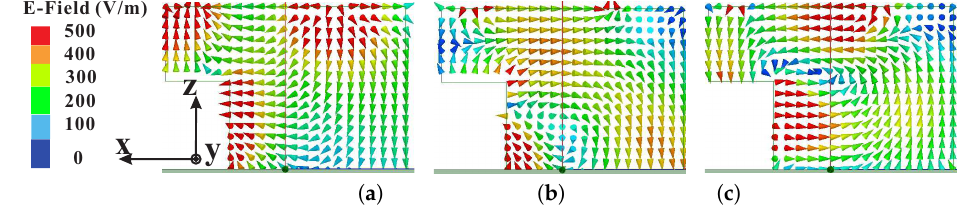
Figure 4. Simulated electric field (E-field) distribution at the center of the modified hexagonal dielectric resonator (DR) for axial ratios (ARs) minima: ( a ) 1.865 GHz; ( b ) TE 111 mode at 2.67 GHz; ( c ) quasi-TE 111 mode at 3.645 GHz.